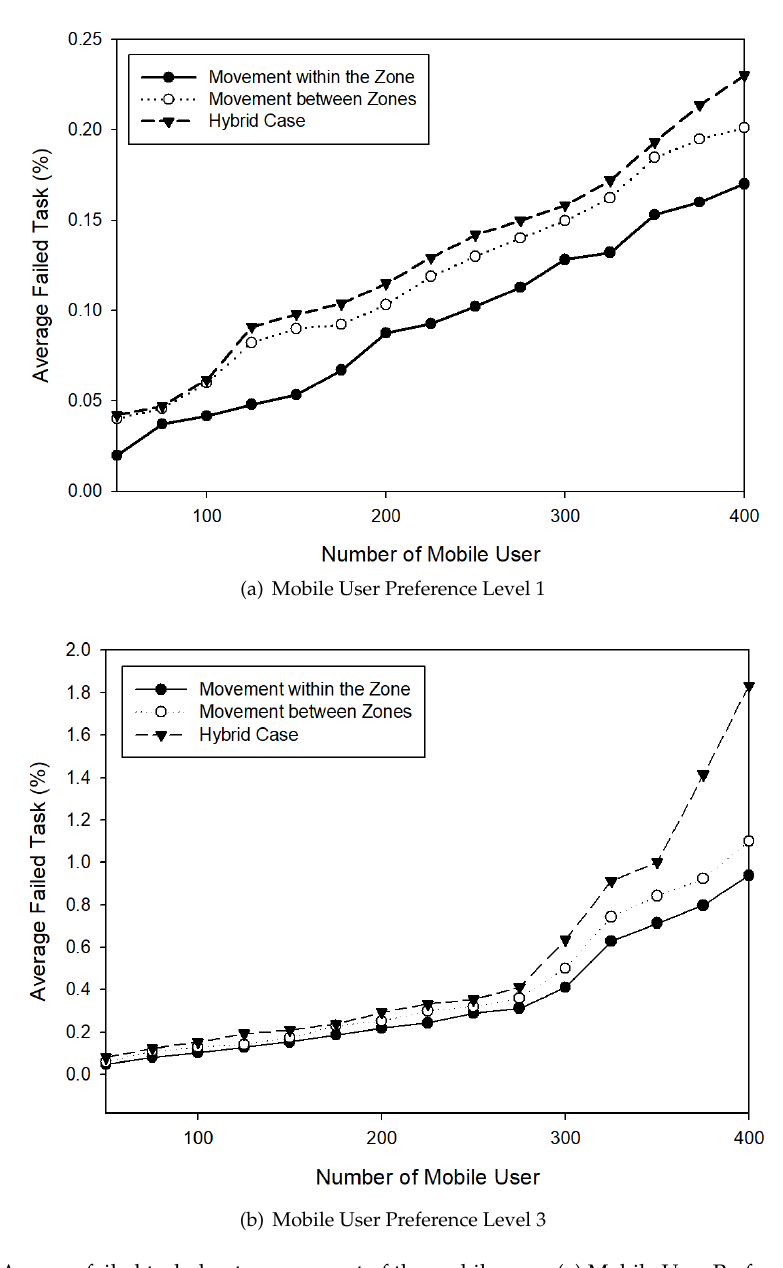
Figure 10. Average failed task due to movement of the mobile user: ( a ) Mobile User Preference Level 1; and ( b ) Mobile User Preference Level